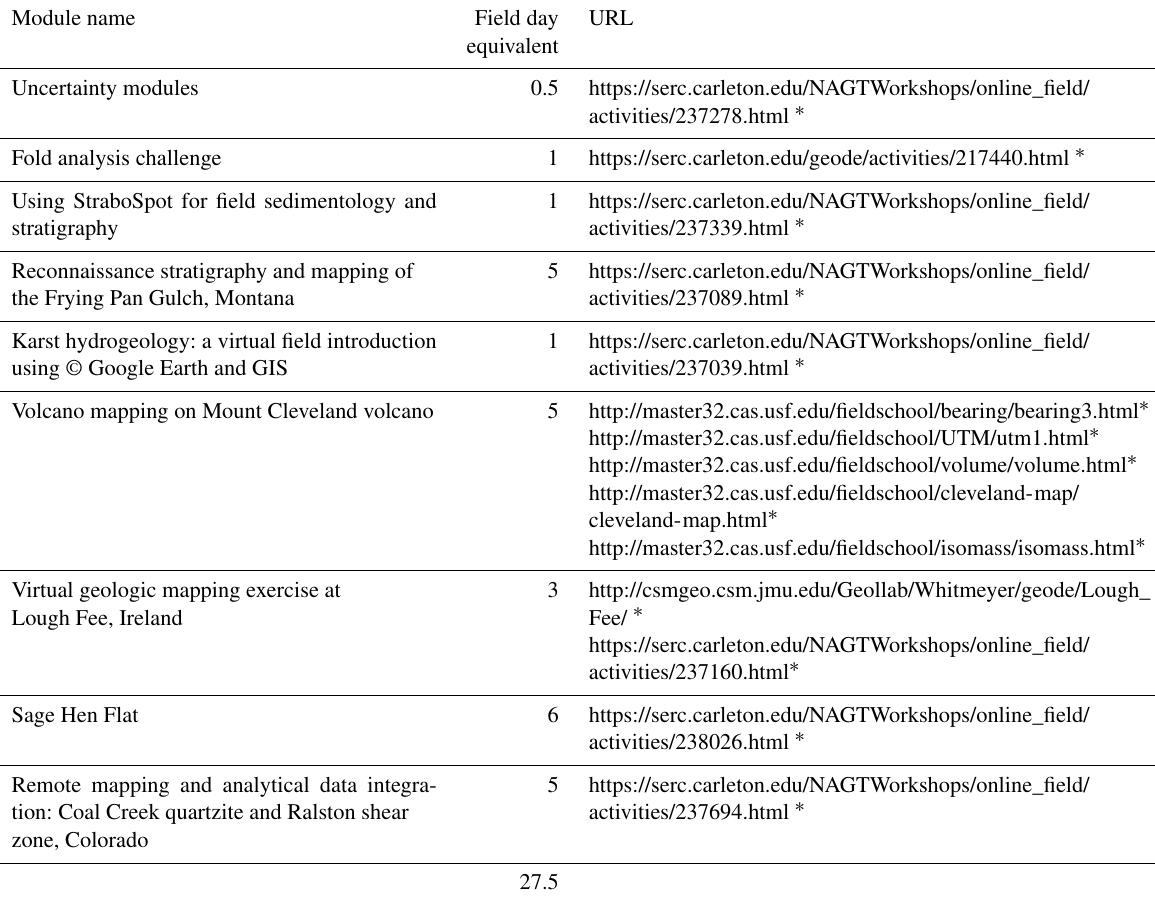
Table 3. Modules for traditional geology virtual capstone